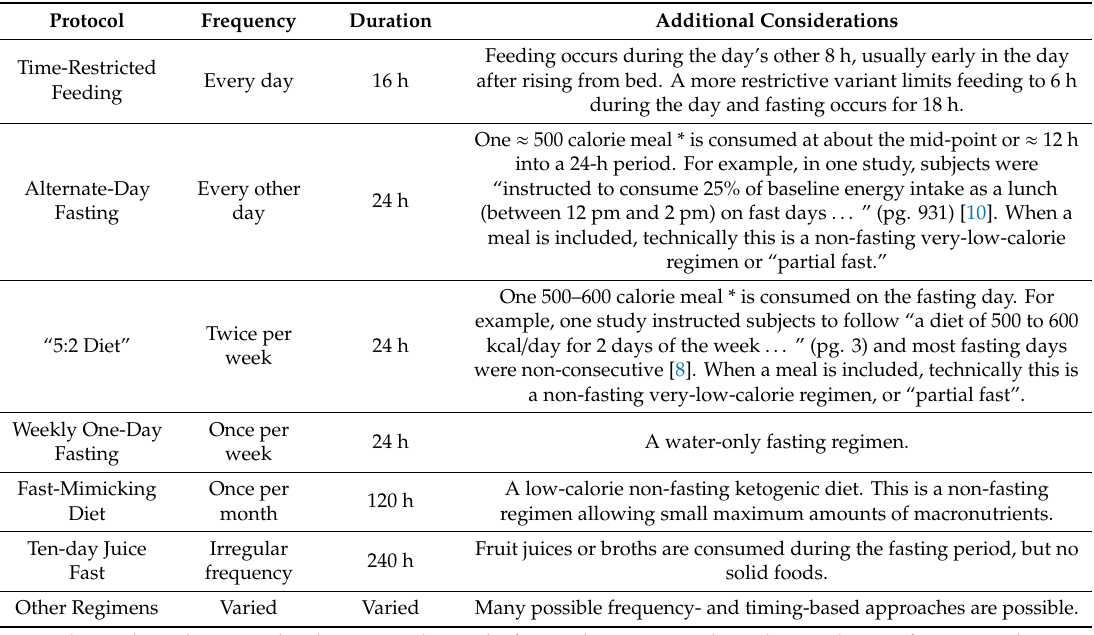
Table 1. Di ff erent protocols labeled intermittent